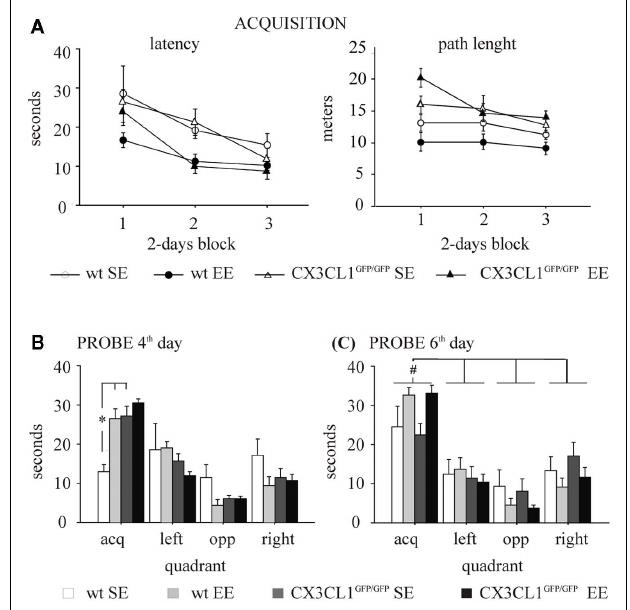
FIGURE 3 | Morris water maze in wt and CX 3 CR1 GFP/GFP mice exposed to either SE or EE condition. (A) Acquisition. Left: latency to find the platform. All subjects learnt to find the platform. However, EE mice, independently from their genotype, showed a significant reduction in escape latency compared with SE mice. Right: path length to find the platform. A main effect of genotype was found for path length, CX 3 CR1 GFP/GFP swimming longer paths than wt during the acquisition phase. (B) Probe on the fourth day. SE CX 3 CR1 GFP/GFP mice spent an amount of time similar to that spent by EE CX 3 CR1 GFP/GFP mice and significantly longer than that spent by SE wt mice. (C) Probe on the sixth day. All experimental groups spent significantly more time in the quadrant where the platform had been located during training than in the other quadrants.The EE mice showed a better learning performance than SE mice, independently from their genotype. * p < 0.05 vs. both EE wt and SE CX 3 CR1 GFP/GFP mice. # p < 0.05 vs. the other quadrants for each experimental group. Data are mean ± SEM.